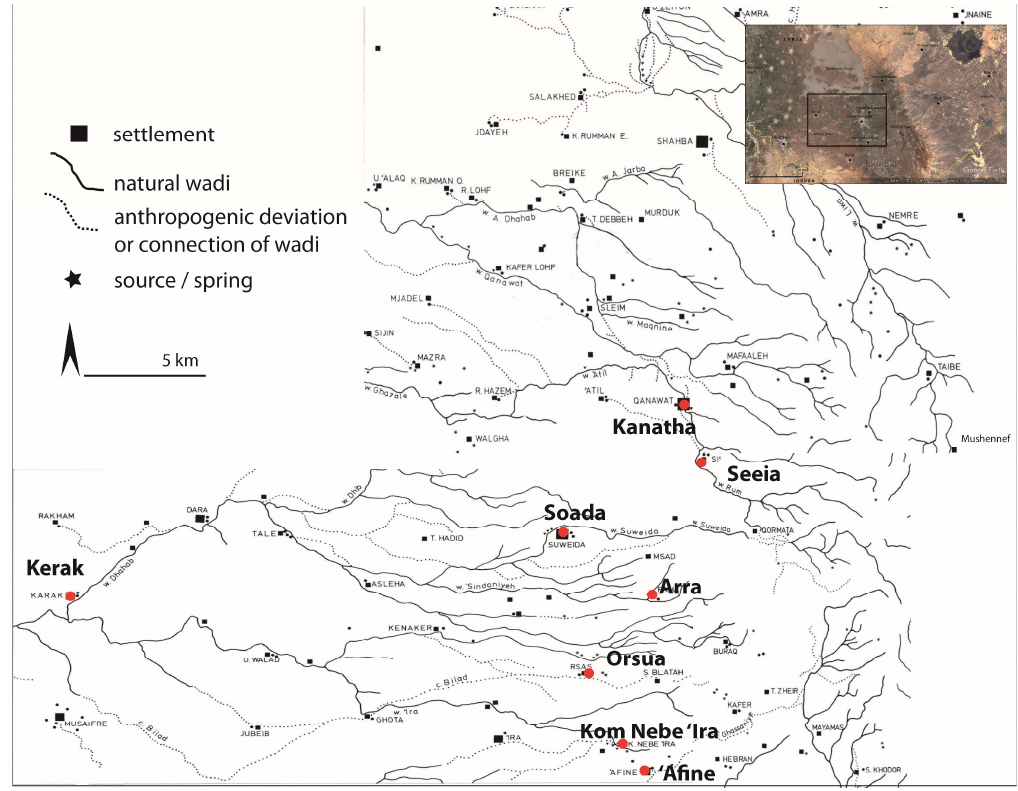
Figure 4. Map of wadis, sources, and deviation channels in the northern parts of Hauran. Assembled by the author from F. Braemer [60], his Figures 5–7 as base maps.